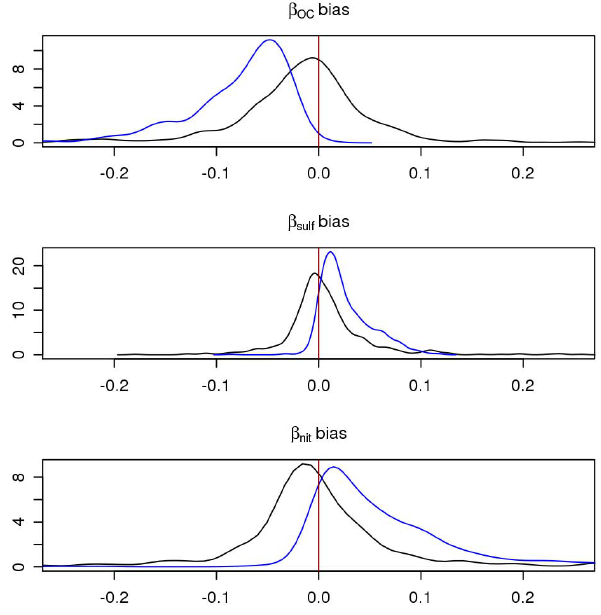
Fig. 3. Distribution of bias in regression coefficients for quarter- specific regressions at all IMPROVE sites. For each technique, we compute the median bias from 200 synthetic datasets at each site/quarter using ordinary least squares (blue) and errors-in- variables regression (black) and plot the distribution of those me- dian values across all 612 site- and quarter-specific regressions. The red vertical line shows zero